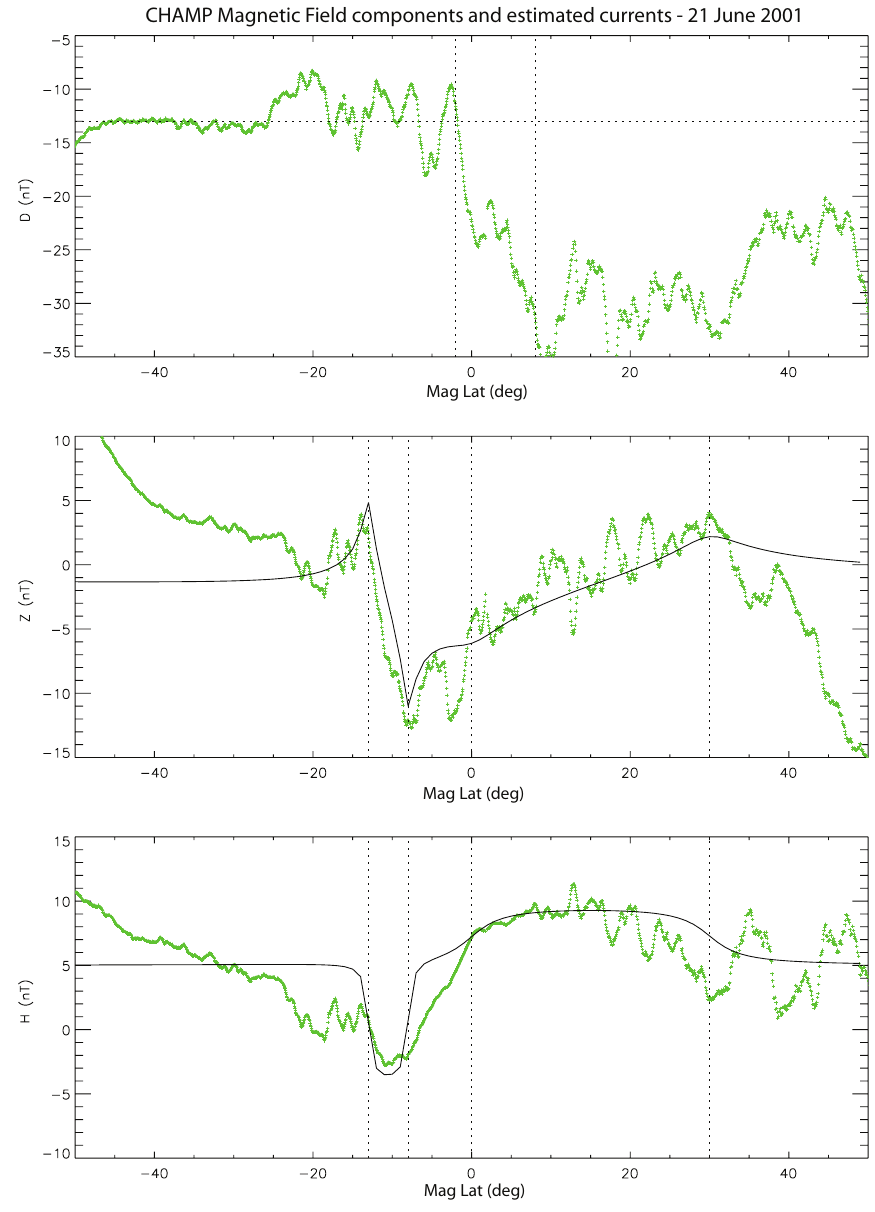
Fig. 8. Magnetic variations of the D (upper panel), Z (middle panel) and H (lower panel) components as measured by CHAMP. The estimated profiles due to modelled currents in the indicated regions (dotted lines) are shown by the black